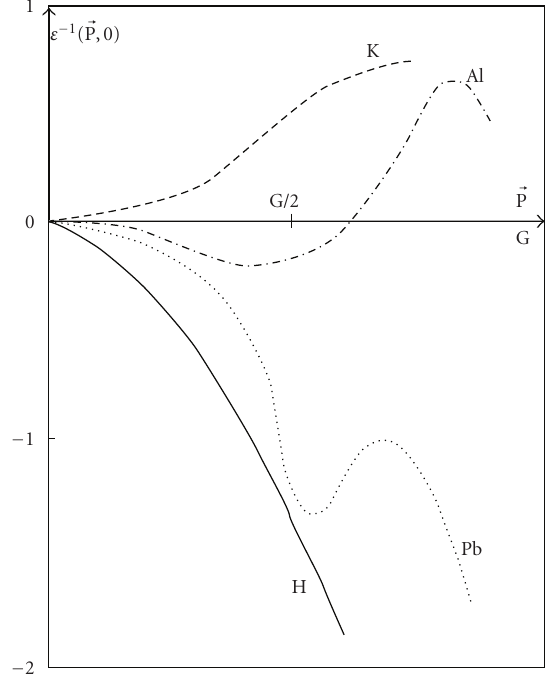
Figure 1: Inverse total static dielectric function ε − 1 ( p ) for normal metals (K, Al, Pb) and metallic H in p = (1,0,0) direction. G is the reciprocal lattice